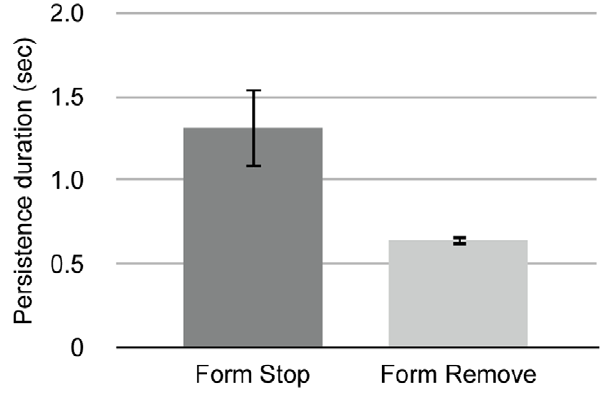
Figure 2. Subjective persistence of static form after motion offset. Times, post physical motion offset, at which observers reported that no coherent structure was visible in the display. When form was seen to move then stop, observers took longer to report that no coherent structure remained compared to when the coherent structure was physically removed at motion offset. Error bars depict + / 2 1